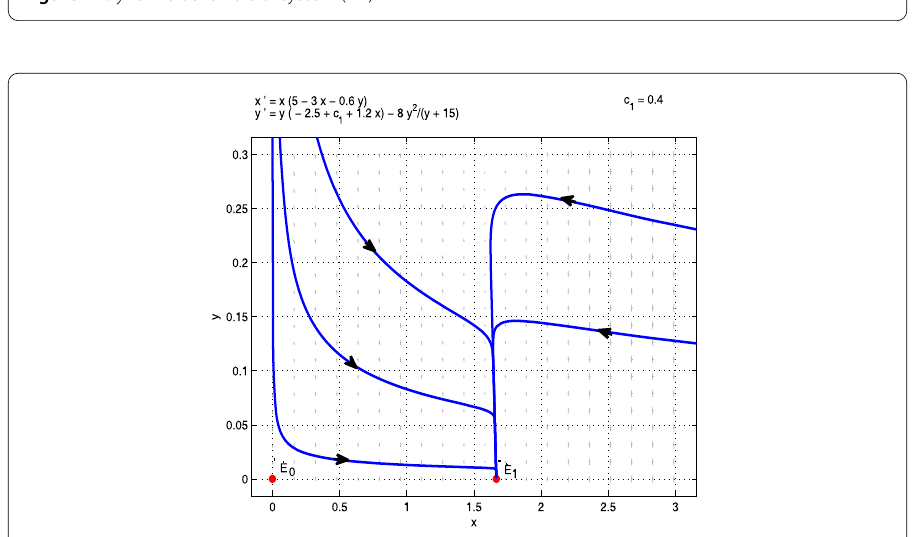
Figure 1 Dynamic behaviors of system (4.1)